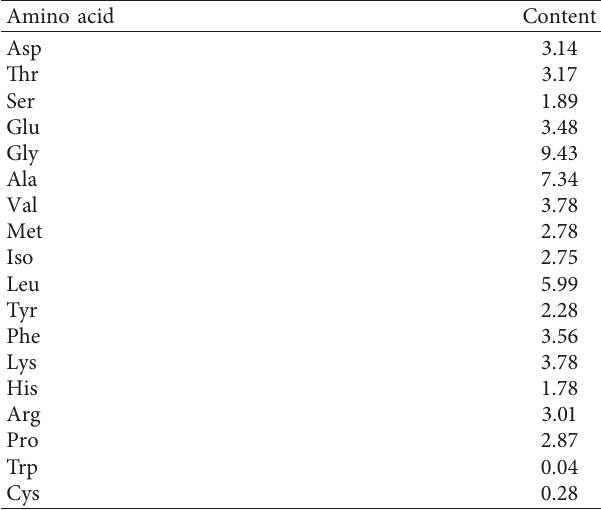
Table 3: Amino acid compositions of fraction I(%) (g/100g